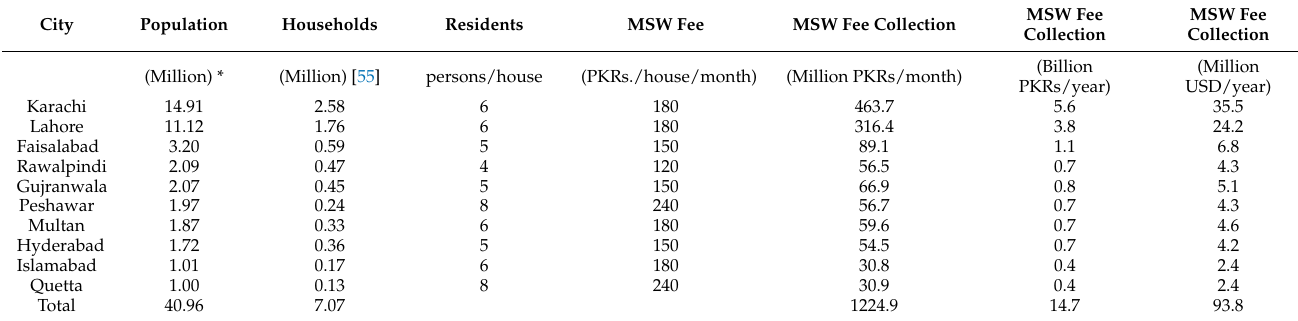
Table 12. Estimated financial outcome form proposed MSW services